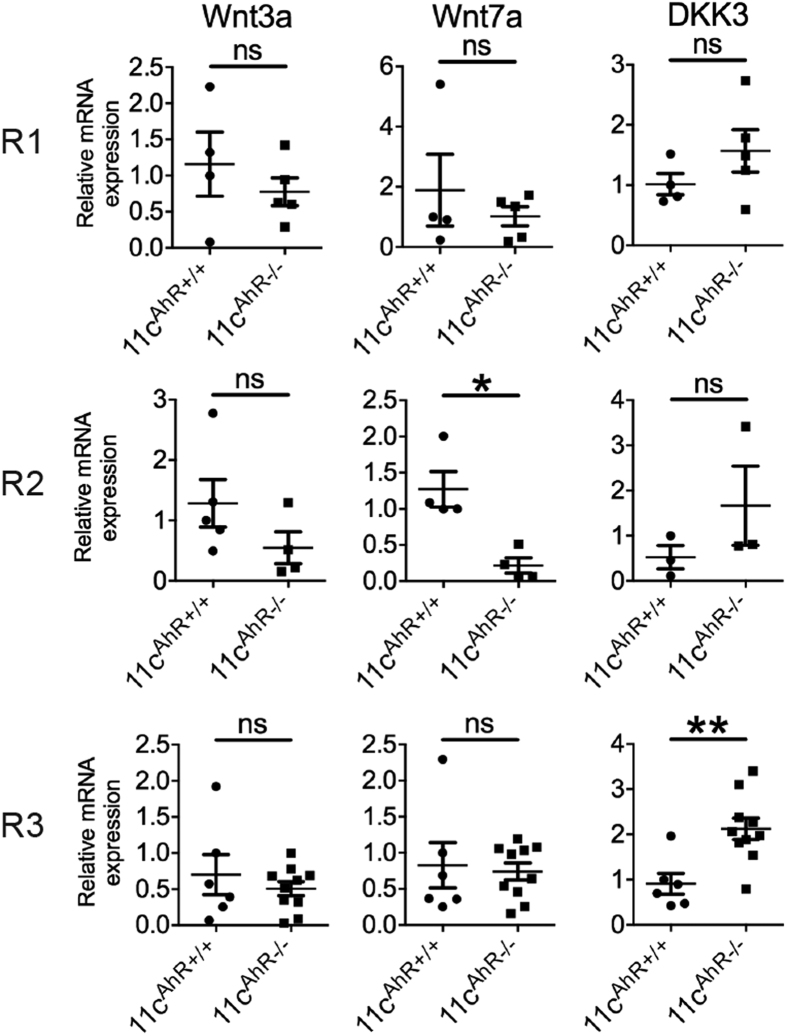
Intestinal LP APCs from 11cAhR−/− mice exhibit aberrant expression of Wnt signalling constituents.Quantitative RT-PCR performed on cDNA generated from FACS sorted populations corresponding to R1, R2 and R3 APC subsets. Each symbol represents data from one single mouse. Data presented as ±SEM were pooled from 3–5 independent experiments. Mann-Whitney test: *P < 0.05; **P < 0.01; ns, not significant.